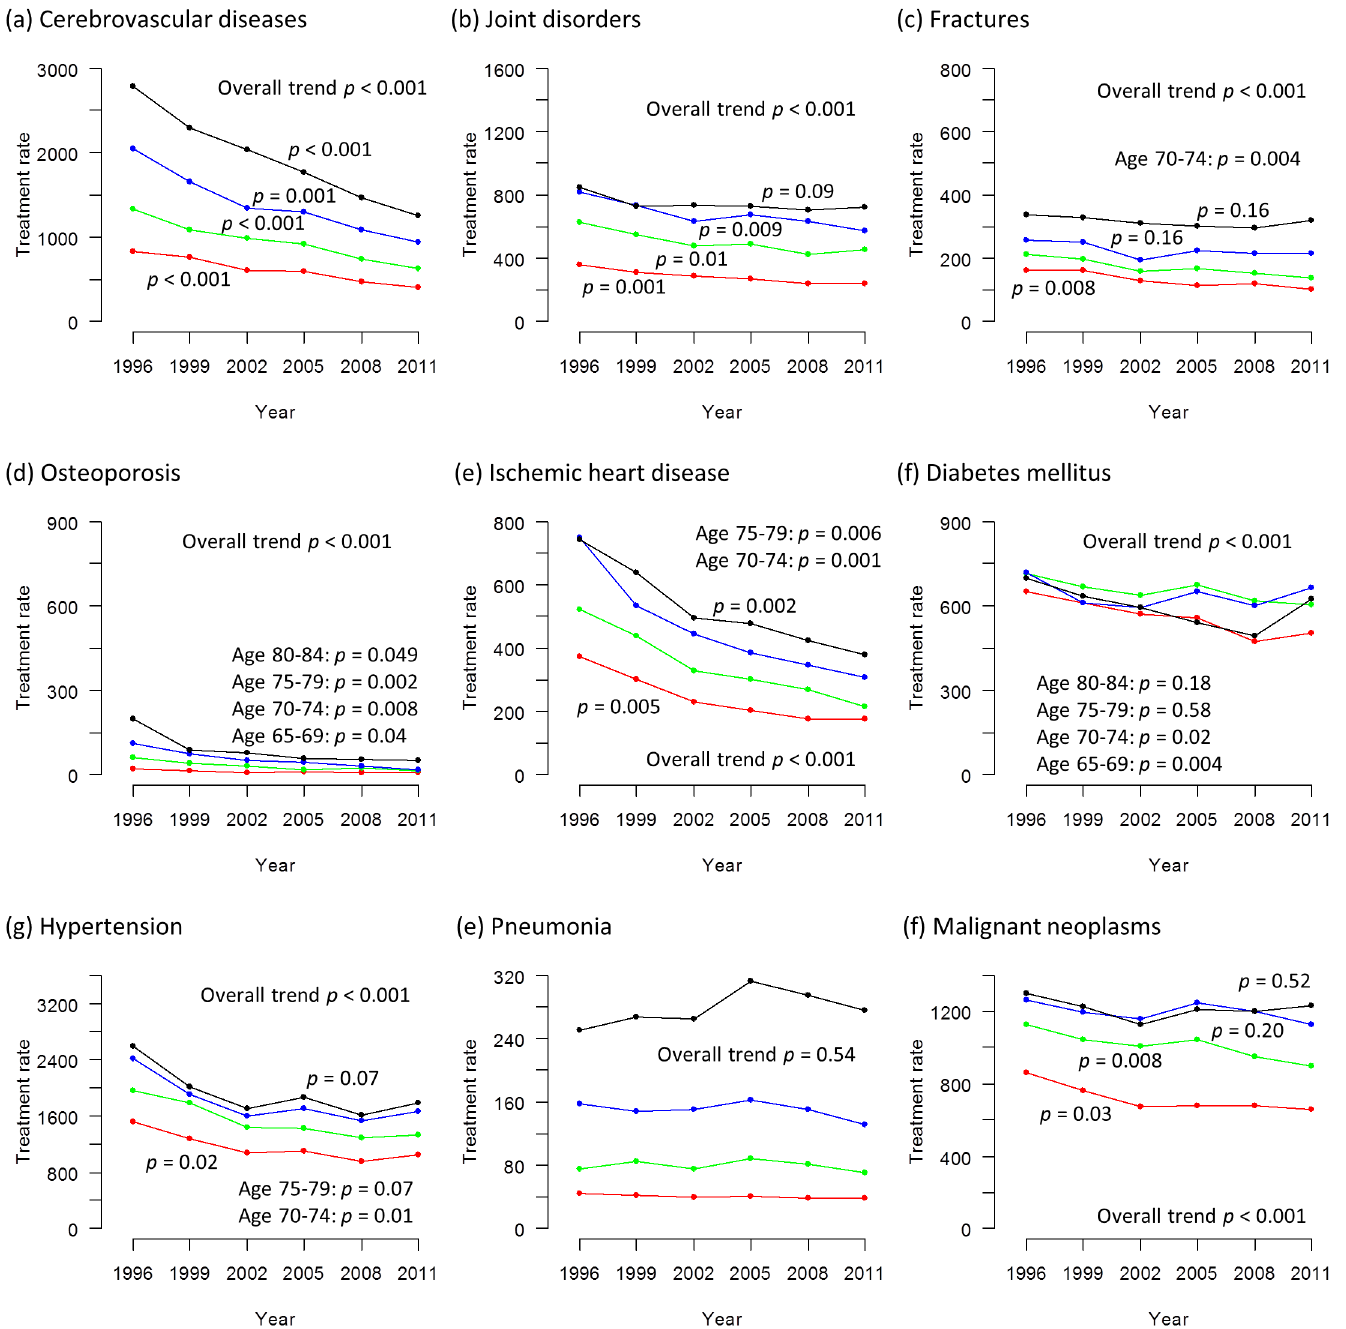
Fig 2. Trends in treatment rates of nine selected medical conditions in men from 1996 to 2011. (a) cerebrovascular diseases (b) joint disorders (c) fractures (d) osteoporosis (e) ischemic heart disease (f) diabetes mellitus (g) hypertension (h) pneumonia (i) malignant neoplasms The treatment rate is calculated as the estimated number of patients divided by the estimated population x 100,000. The black line represents those aged 80 – 84 years, the blue line represents those aged 75 – 79 years, the green line represents those aged 70 – 74 years and the red line represents those aged 65 – 69 years. The p values signify statistical significance for the trends in each age